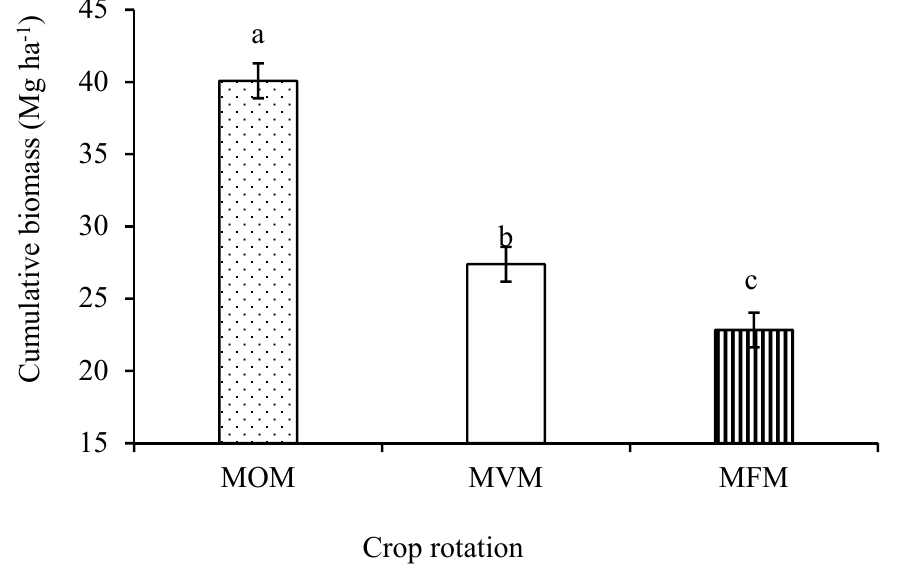
Figure 1. Crop rotation effects on cumulative biomass production (Mg ha − 1 ) for six seasons (2015–2017). Different lowercase letters indicate significant differences at p < 0.001.